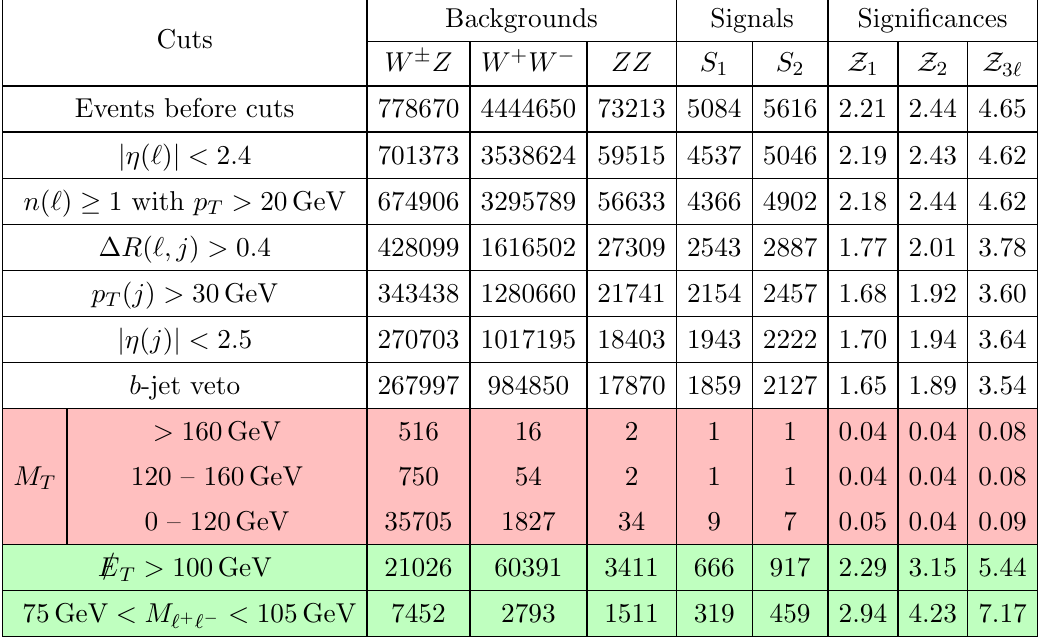
Table 3. Cut-(cid:13)ow for S 1 , S 2 and the SM backgrounds for BP1, at the LHC with L = 300 fb (cid:0) 1 . The numbers in the last two (green-shaded rows) are obtained by disregarding the cuts on M T (shown in the red-shaded